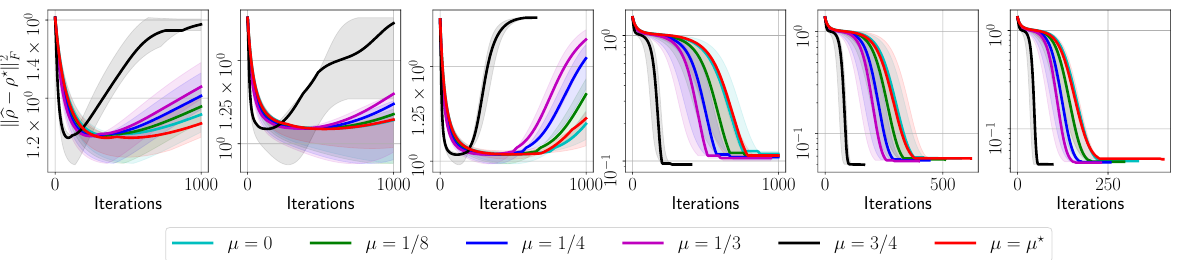
( 6 ) circuit using synthetic measurements −